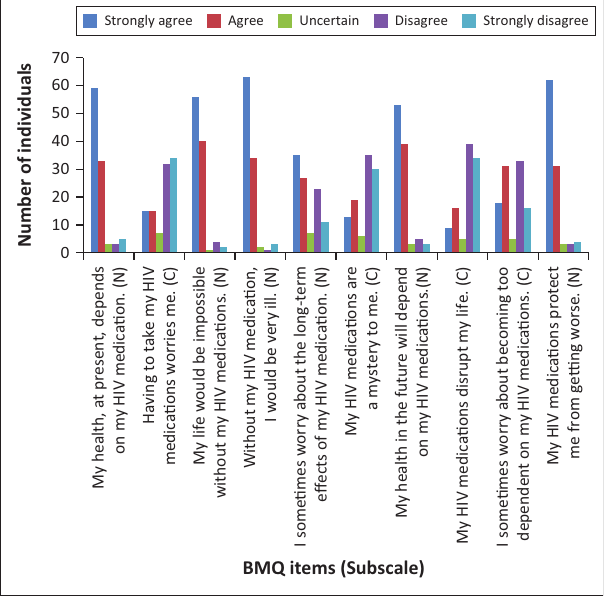
FIGURE 2: Participant responses to BMQ items ( N = 10 3 ). BMQ items are listed on the horizontal axis, with letters in parentheses indicating the subscale. N, BMQ-Necessity item; C, BMQ-Concerns item; BMQ, Beliefs about Medicine